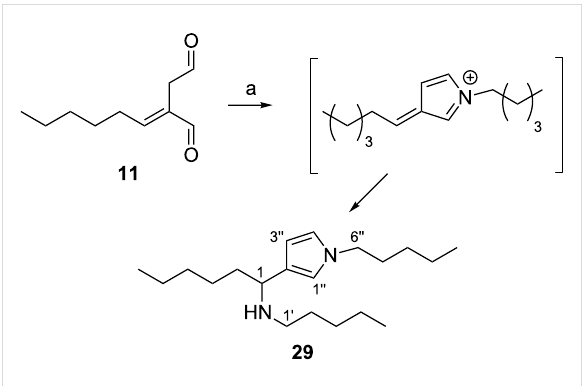
Paal–Knorr pyrrole formation to form an azafulvenium interme- diate which is subsequently quenched with another mole of amine nucleophile to form the observed product (Scheme 5).